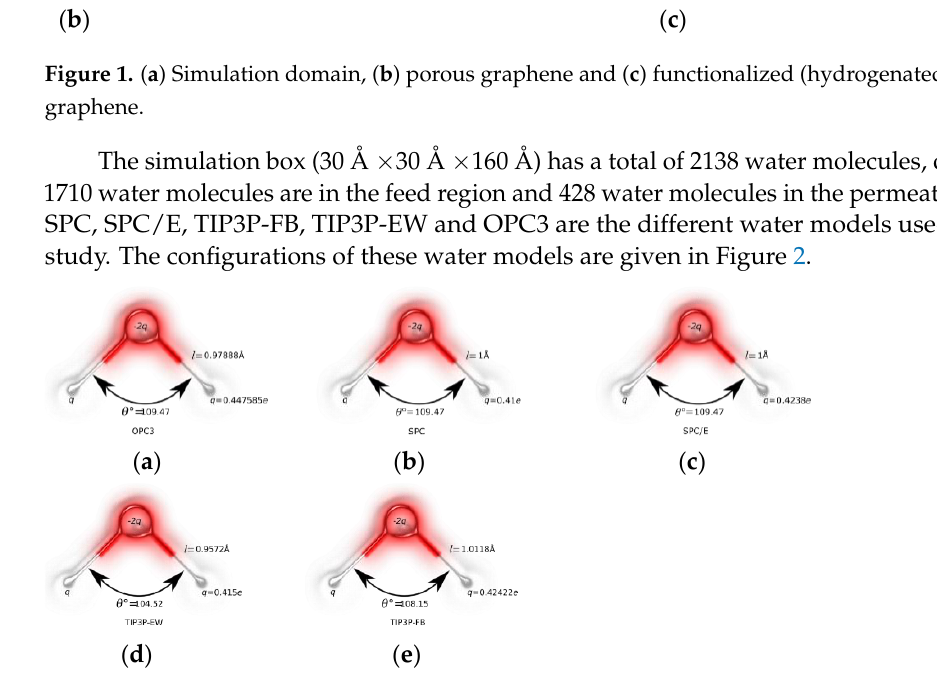
Figure 2. Different water models used in this study. ( a ) OPC3; ( b ) SPC; ( c ) SPC/E; ( d ) TIP3P − EW; ( e ) TIP3P − FB.